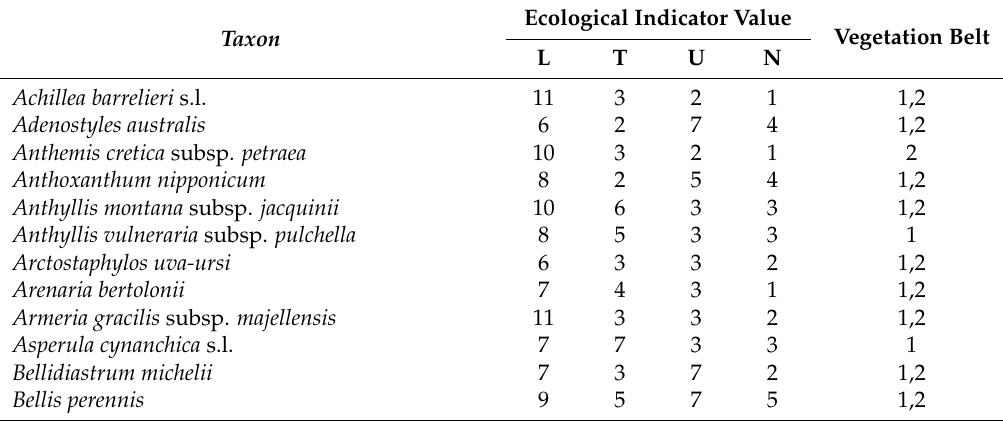
Table A1. The complete list of species along with the corresponding ecological indicator values of light availability (L), temperature (T), soil moisture (U), soil fertility (N) [48], and species occurrence in the analyzed vegetation belts. The lower subalpine belt (from 1750 up to 2100 m a.s.l.) is indicated by 1, and the upper subalpine belt (from 2100 up to 2420 m a.s.l.) is indicated by